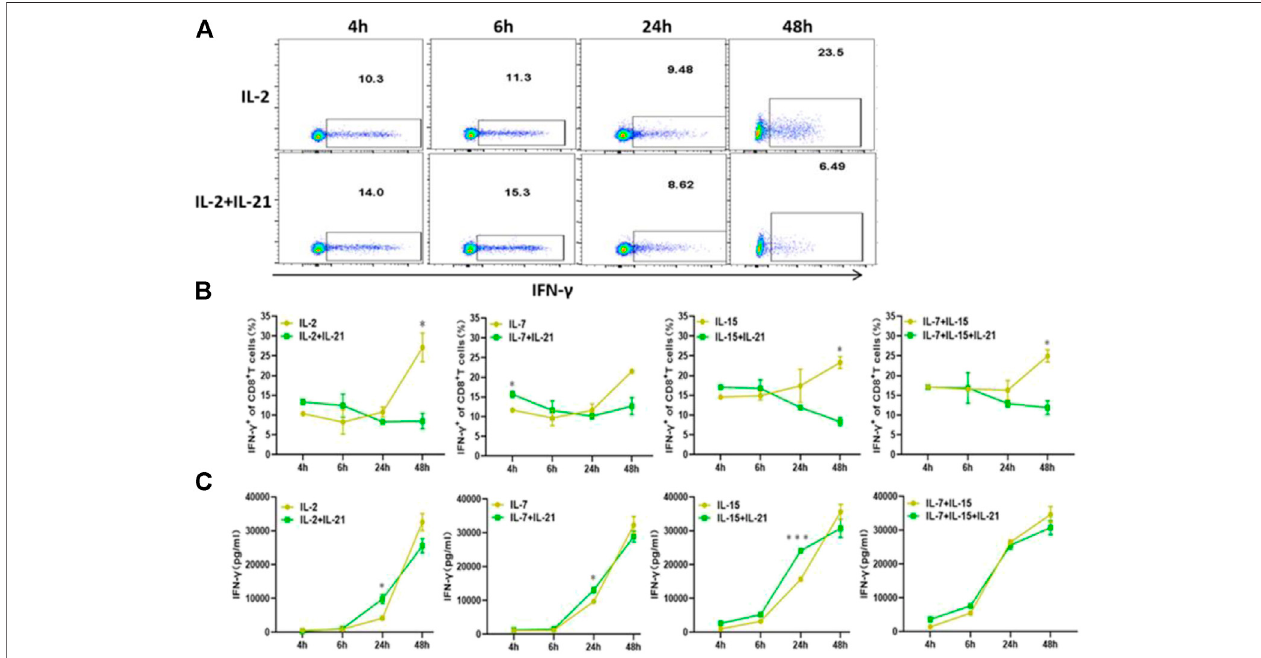
FIGURE 4 | IL-21 in fl uence the IFN- γ expression. (A,B) Percentages of IFN- γ + T-cells among CD8 + T cells at different activation time points were evaluated by intracellularFACSassay.Results from fl owplotsofonerepresentative donorandsummarydataforindicatedCAR-Tcellgroupwereshown. (C) IFN- γ concentraction in different culture supernatants was detected by ELISA at various time points after stimulation. Each experiment was performed in triplicate, and error bars represent ± SEM. Statistical signi fi cance was tested using Students ’ s T -test (* p < 0.05, ** p < 0.01, *** p < 0.001).